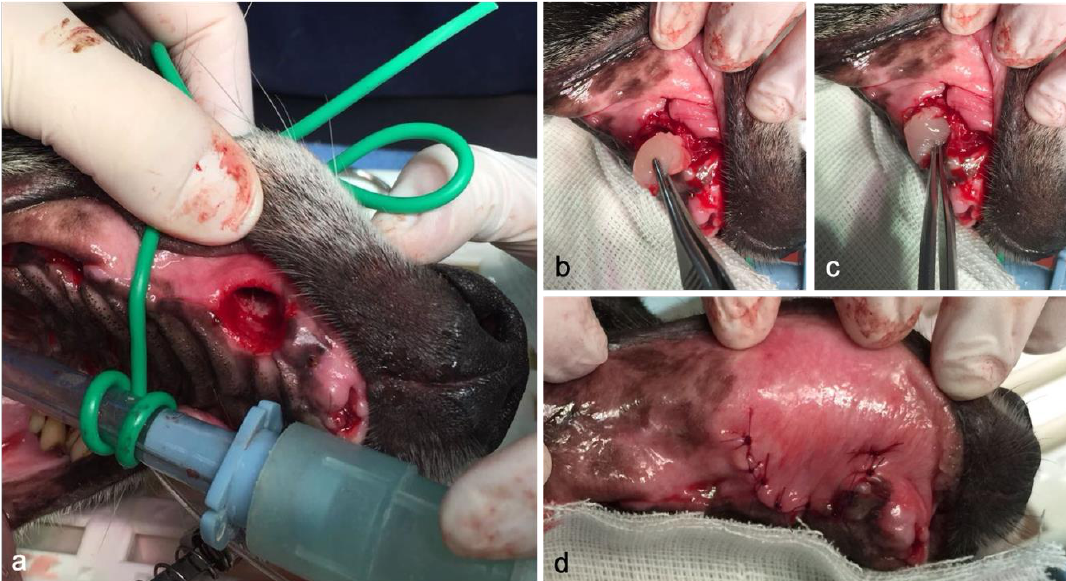
Figure 2. Surgery procedure and PRF application: ( a ) alveolar socket immediately after dental extraction; ( b ) application of PRF inside the post-extraction alveolar sockets; ( c ) post-extraction socket filled with autologous PRF plug; ( d ) apposition of mucogingival flap and suturing with monofilament material.